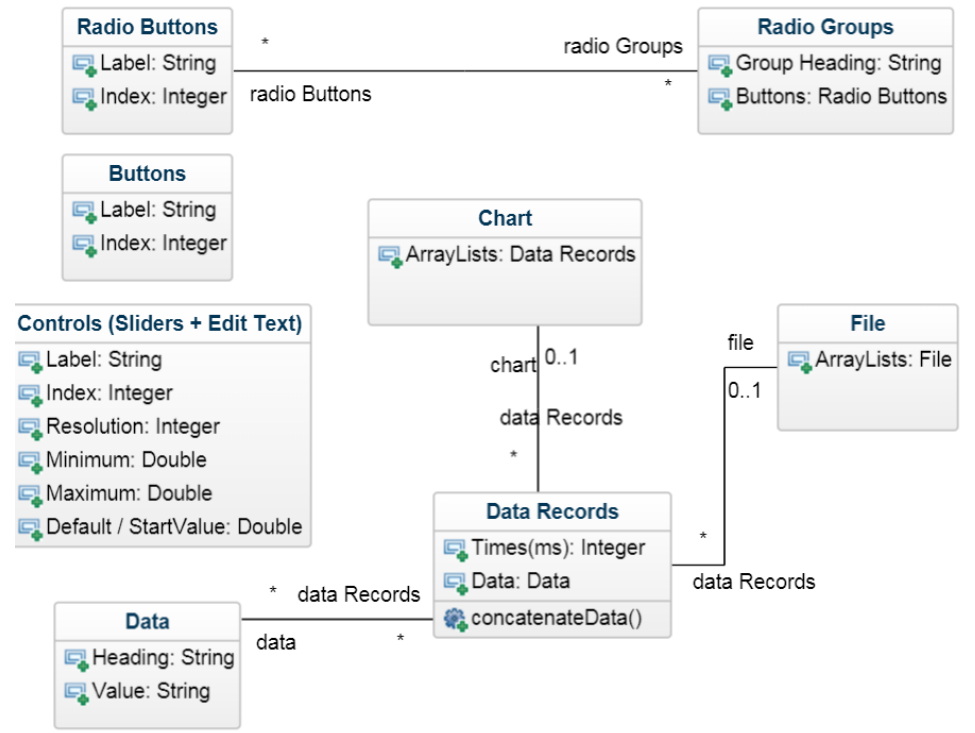
Figure 1. Class Diagram for ABE-VIEW app illustrating the attributes of various elements of the GUI, as well as the relationship between data communicated to the app and data records that are plotted on an optional chart or saved as a comma delimited file.